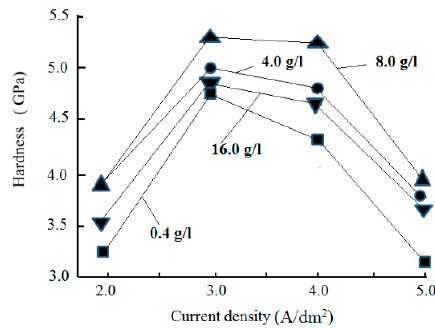
Figure 11. Effect of nanodiamond concentration in the plating solution on the hardness of the composite coating.